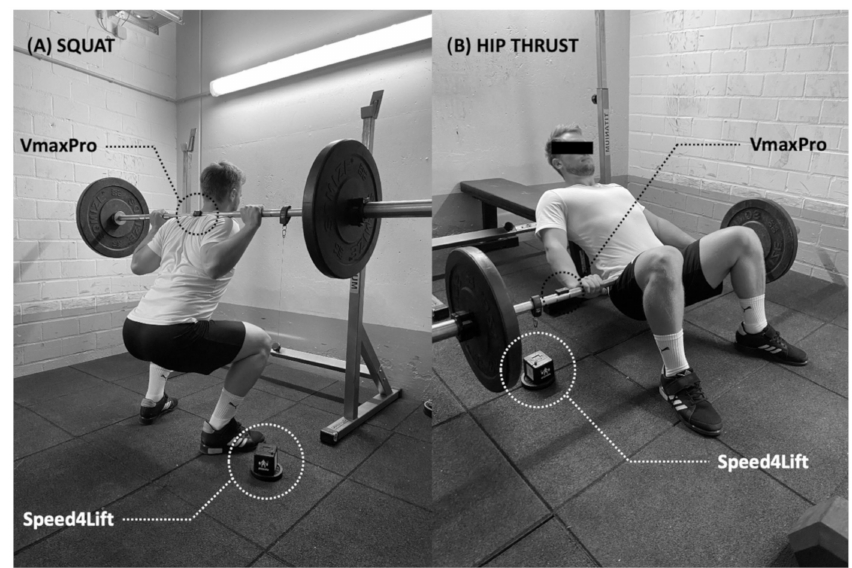
Figure 1. Exemplary execution of the squat ( A ) and hip thrust ( B ) measurement setup. The VmaxPro ® sensor is marked in black and the Speed4Lift ® sensor in